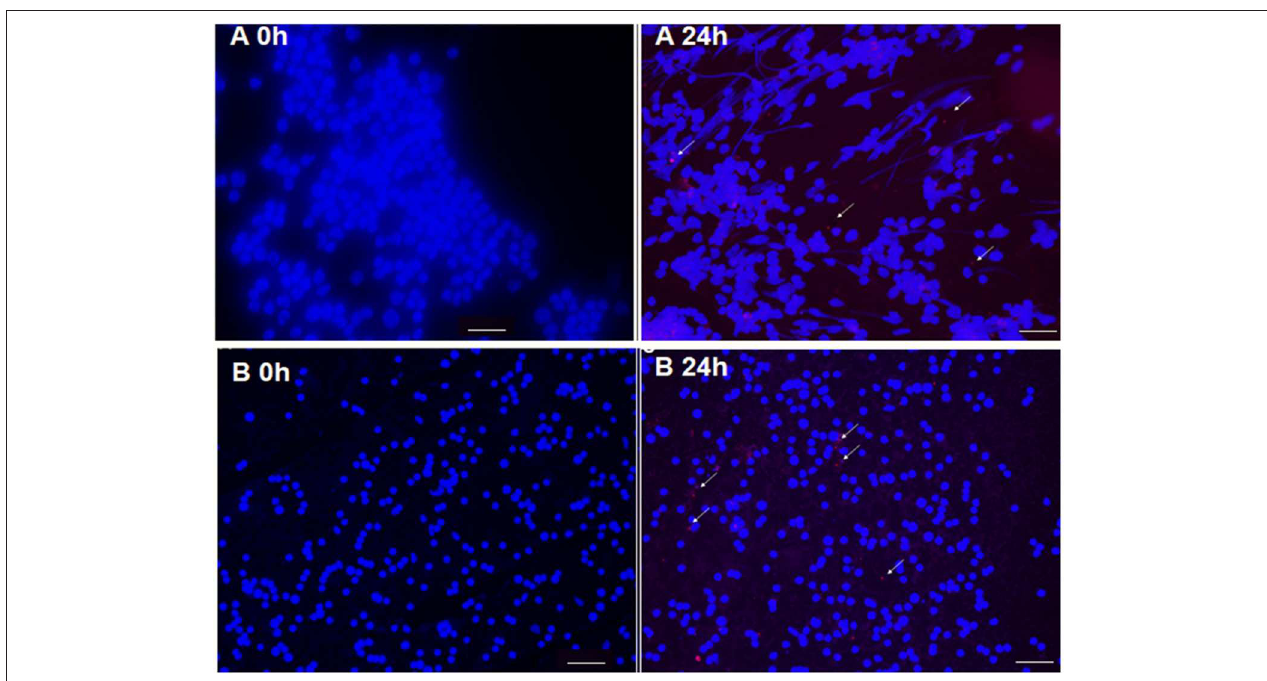
FIGURE 5 | Targeting of liposomes (arrow) labeled with DIL C18 (red) containing sertraline in spleen (A) and liver (B) of BALB/c mice. Ten days after infection, the animals were treated with LP-SERT, spleen and liver were removed, imprinting of each organ have been made in slides, and the samples were submitted to immunofluorescence analyses at 24h. Nucleated cells were labeled with DAPI (blue). White bars represent 50 µ